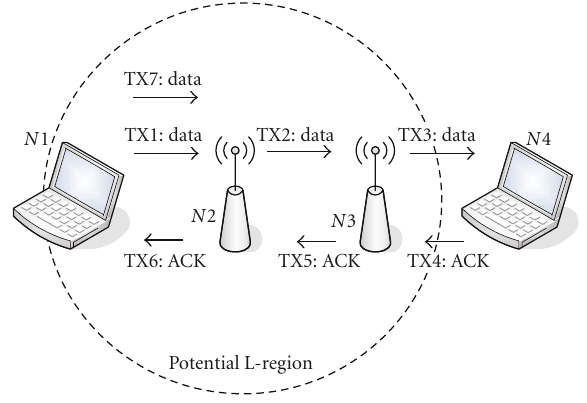
Figure 3: Constant presence of a single flow inside an L-region.